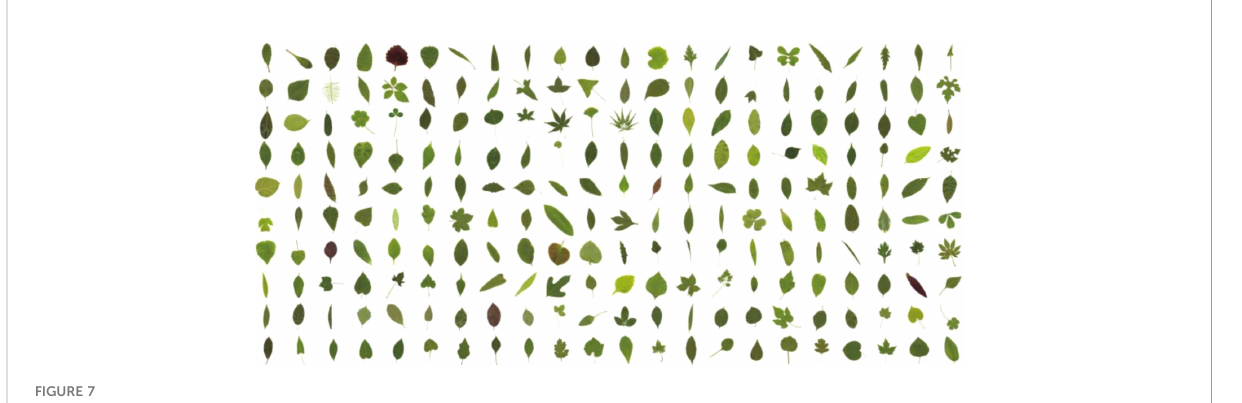
FIGURE 7 Typical samples for each